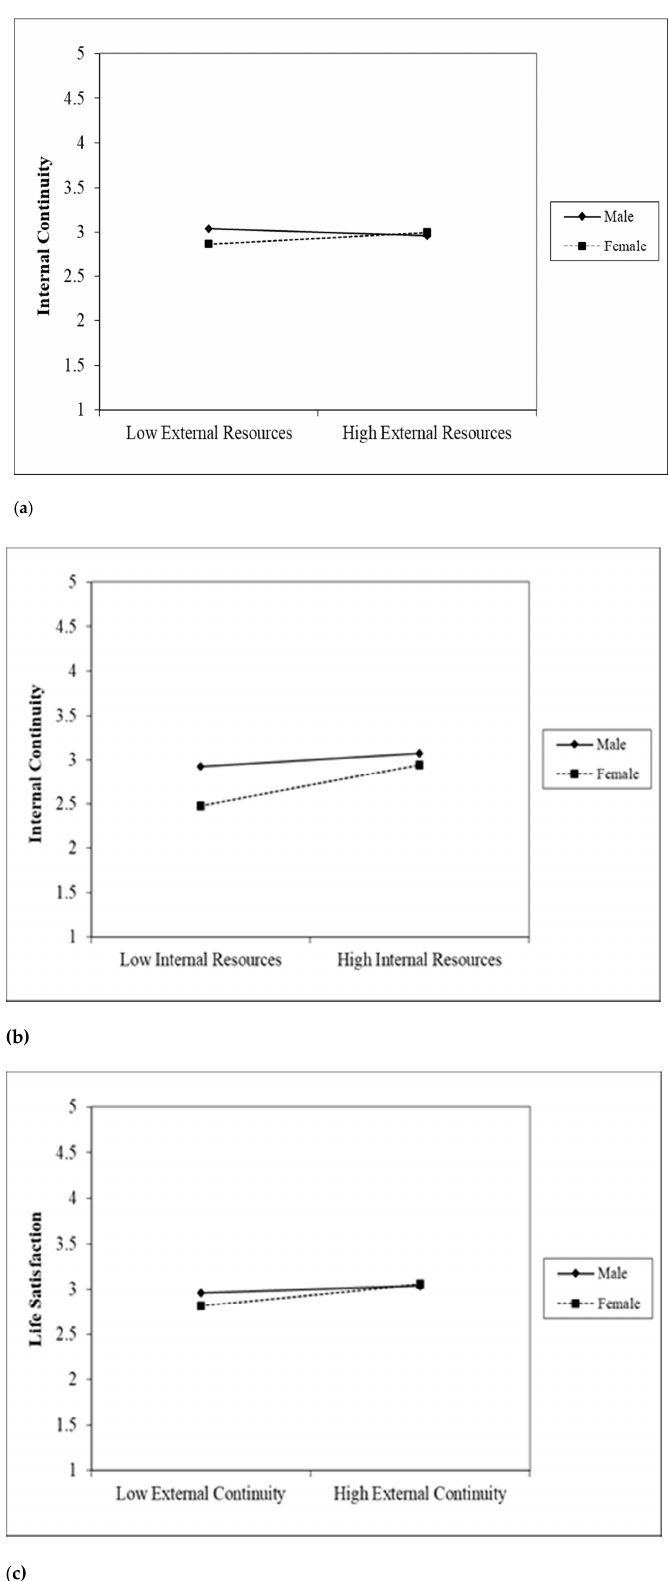
Figure 4. Gender differences in the effects of external and internal resources on continuity and life satisfaction. Note: ( a ) The moderating effect of gender between external resources and internal continuity; ( b ) The moderating effect of gender between internal resources and internal continuity; ( c ) The moderating effect of gender between external continuity and life satisfaction.